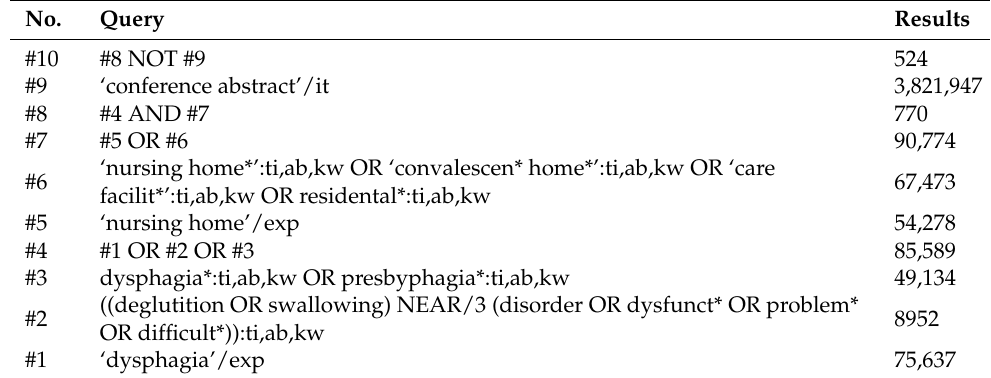
Table A1. Embase.com.